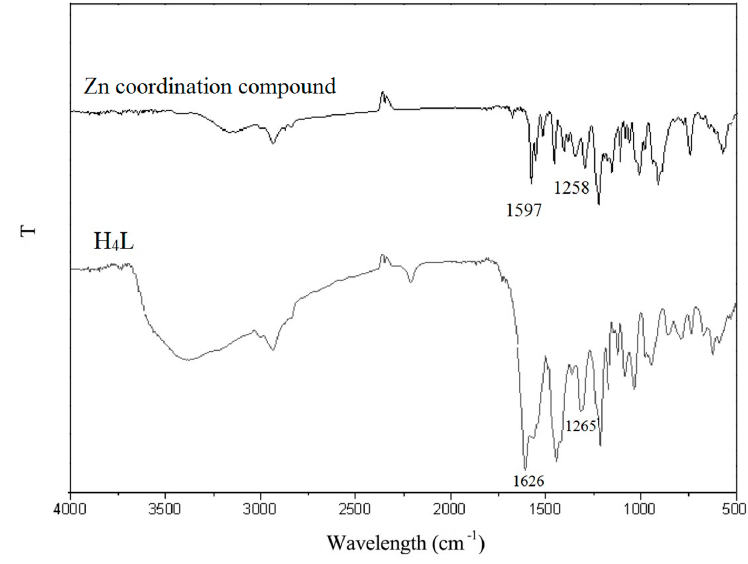
Figure 1. IR spectra of the ligand H 4 L and its Zn II coordination compound.